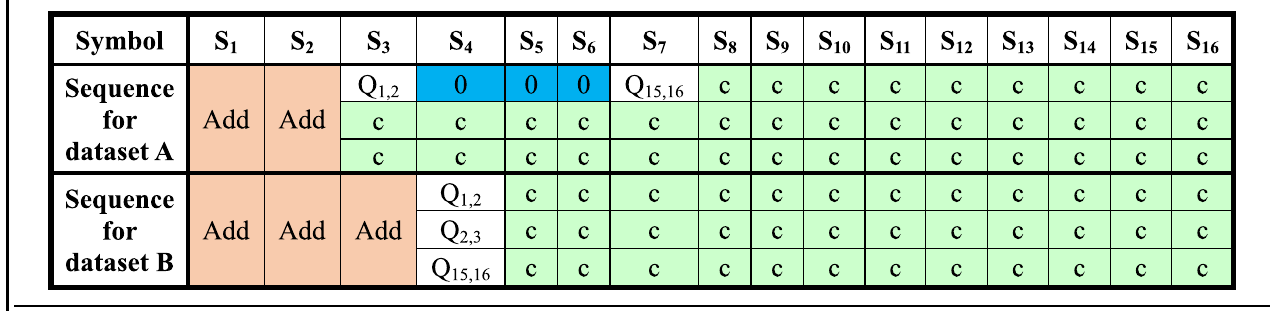
Table 2 Structure of sequences with 16 3-bit symbols, where each 3-bit symbol can be translated to one amino acid according to Table